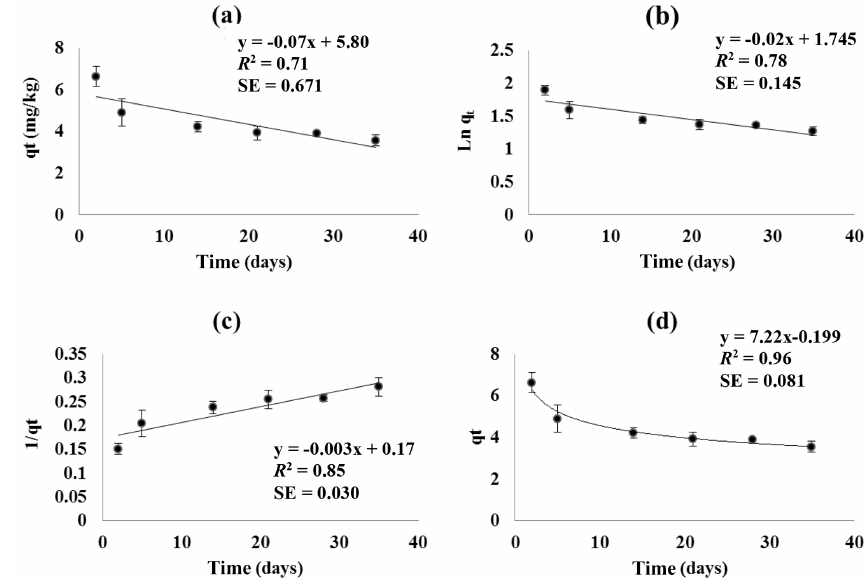
Figure 3. Amount of diethylene triamine pentaacetic acid (DTPA)-extractable copper over the short term (35 days) in the non-chelated system fitted to (a) zero-order, (b) first-order, (c) second-order, and (d) power function models ( q t denotes the amount remaining at time t (mgkg − 1 ); error bars are for standard errors computed from six data points).